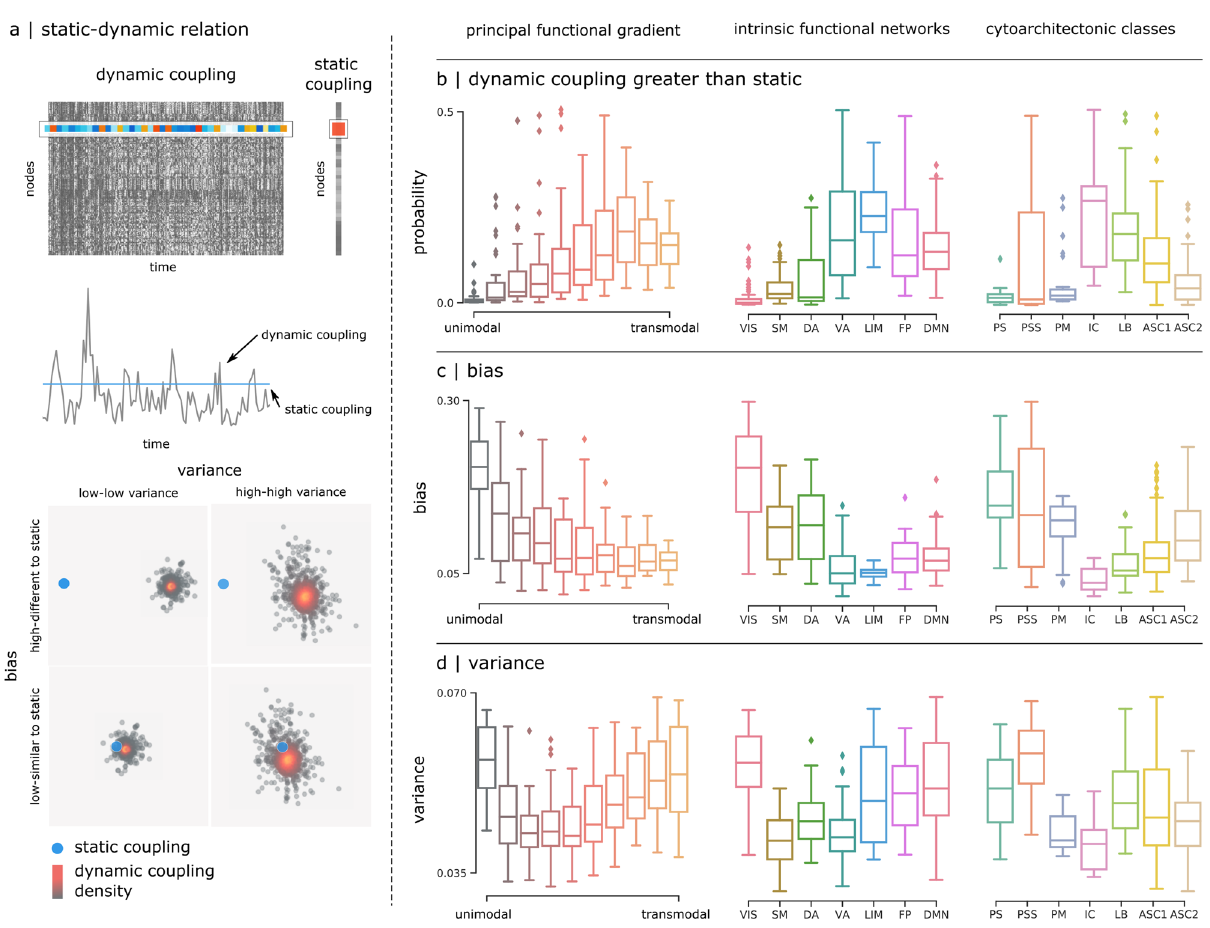
Fig. 4 Relating static and dynamic structure-function coupling. a Top: static structure-function coupling is estimated using the functional connectivity matrix derived from the whole resting-state time-series 23 , and compared with dynamic coupling. The dynamic structure-function coupling of node i corresponds to the i th row of the dynamic coupling matrix, while the static coupling corresponds to the i th element of static coupling vector. Middle: dynamic values represented as a time-series (black line) that fl uctuates around the single static coupling value (blue line). Bottom: dynamic coupling values are represented as a scattered distribution of points (black) around the static coupling value (blue point). The two are compared in different cortical annotations using three summary statistics: b the probability of having a larger dynamic coupling value compared to the static coupling, c the bias, and d the variance of the dynamic coupling to reproduce the static